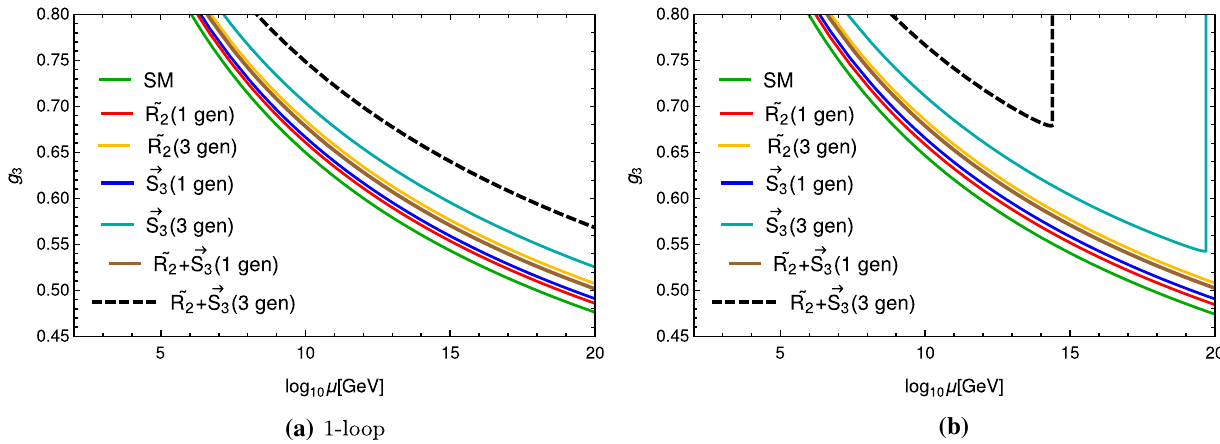
cyan lines, respectively; the brown and dashed black curves illustrate the SM extension with one and three generations of both (cid:2) R 2 and S 3 , respectively. The initial values for SM parameters are listed in Table 1 along with Y φ = 0 .